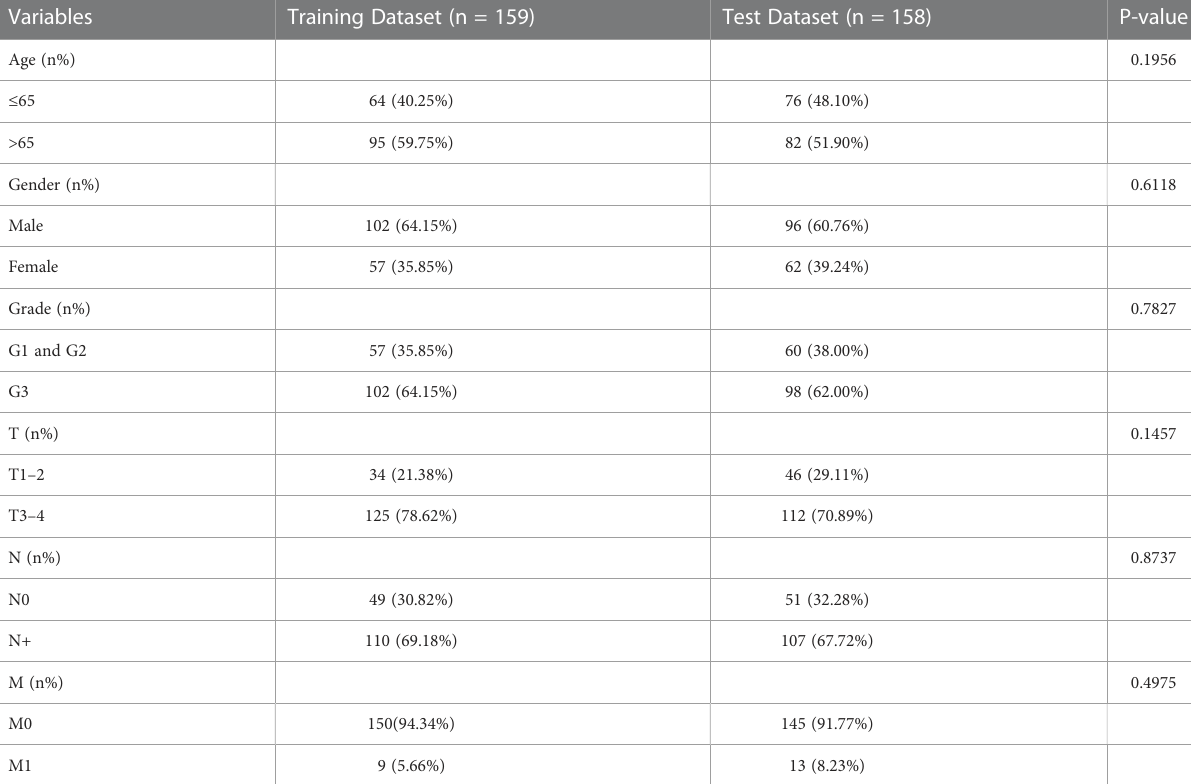
TABLE 1 The baseline of patients in the training dataset and test dataset.